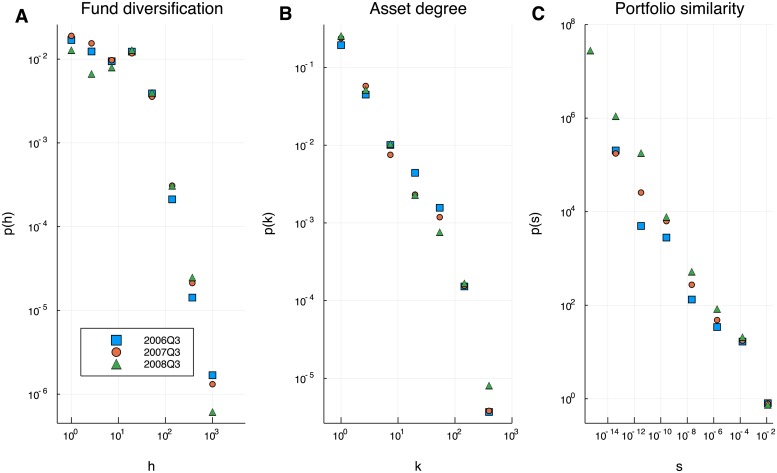
Probability distributions.Probability density functions of the inverse Herfindahl–Hirschmann index h (A), asset degree k (B) and cosine similarity s (C) for three reference quarters. The network is heterogeneous and all the distributions are broad and fat tailed. Most portfolios have few dominant assets but there exist some that have thousands; most assets belong to few funds, but some are extremely popular. Similarities extend over more than 10 orders of magnitude and there exist pairs of almost identical portfolios. Only values s > 0 have been considered to compute the histogram.